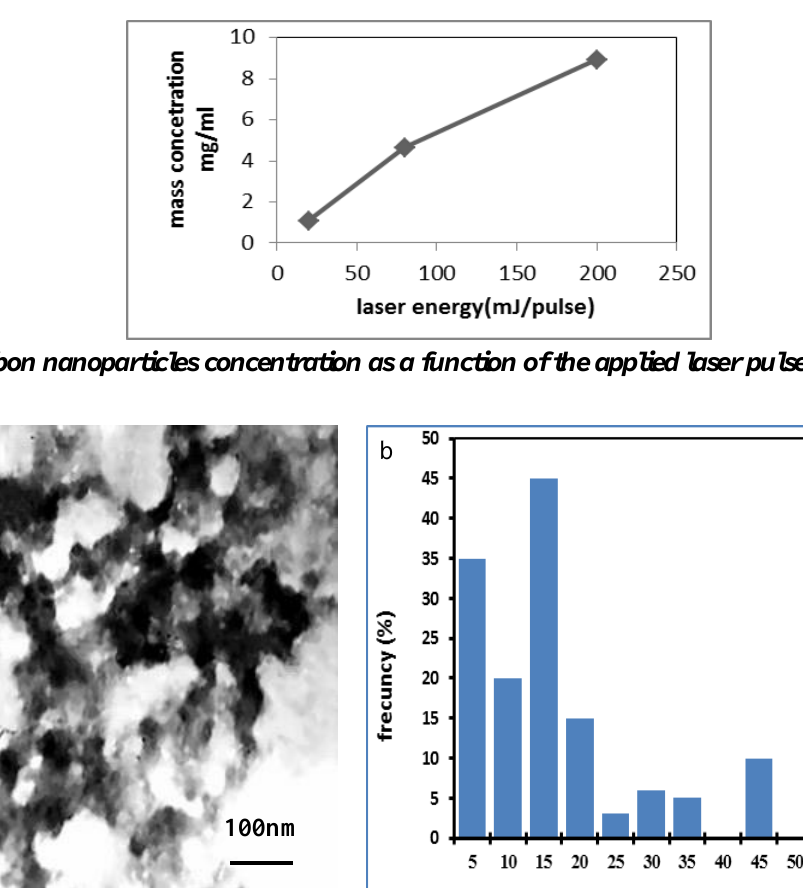
H ) at 205 nm wavelengths. 8 2